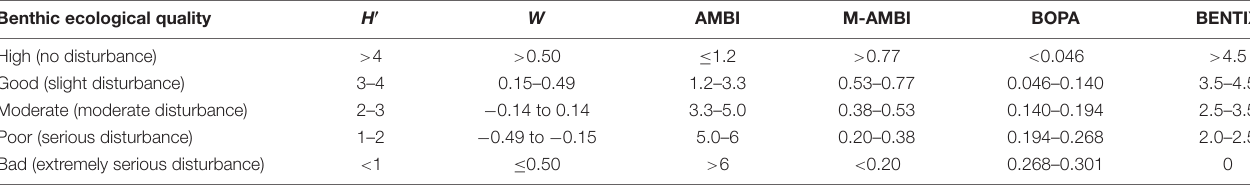
TABLE 1 | Threshold levels of six indices for benthic ecological quality status assessment. Benthic ecological quality H (cid:48) W AMBI M-AMBI BOPA